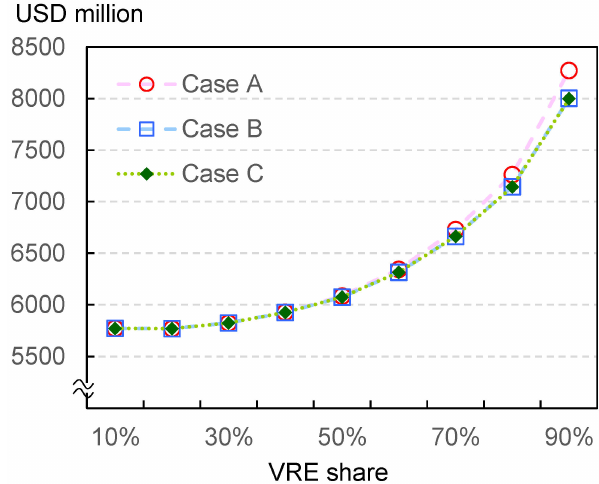
Figure A3. Total system cost by case.